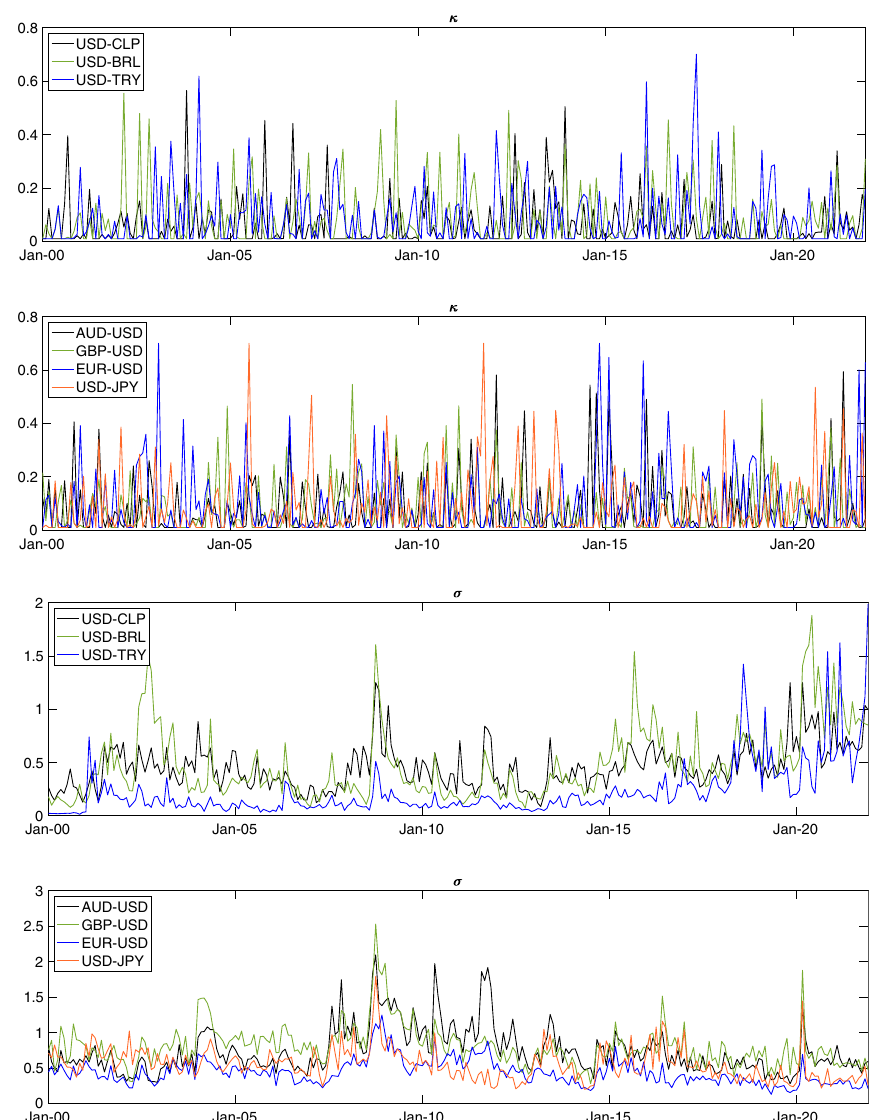
Fig. 8 κ and σ (%) estimations for the daily price dynamics following the Vasicek model of Eq. (12). These values are obtained by calibrating the model with daily data and their average are the values shown